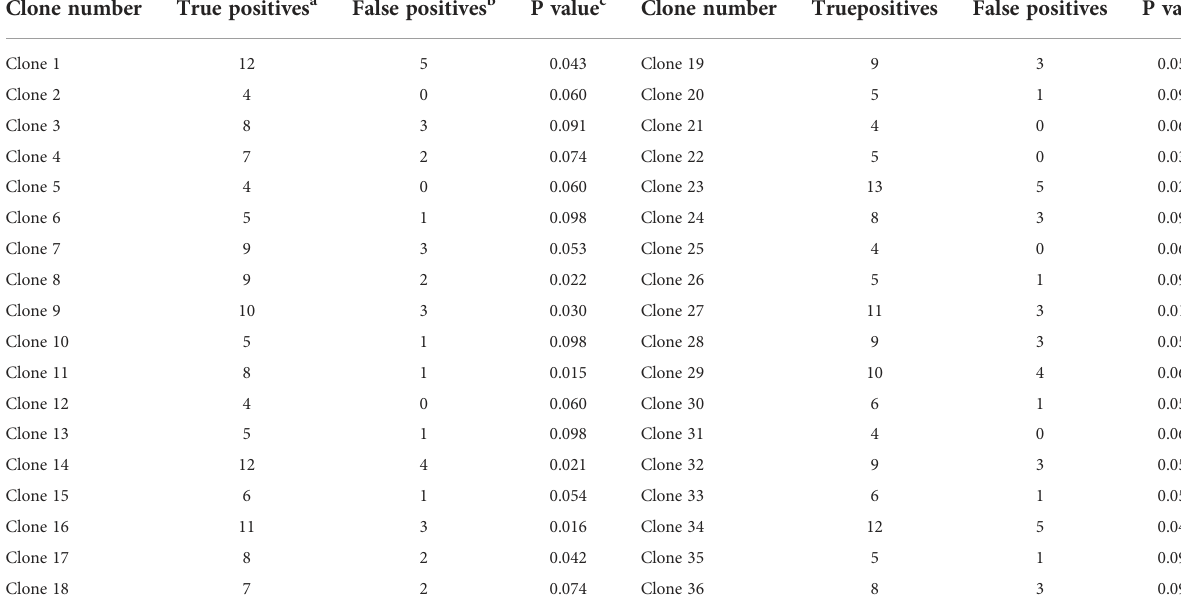
TABLE 5 Results of 36 positive clones in the second round of serum